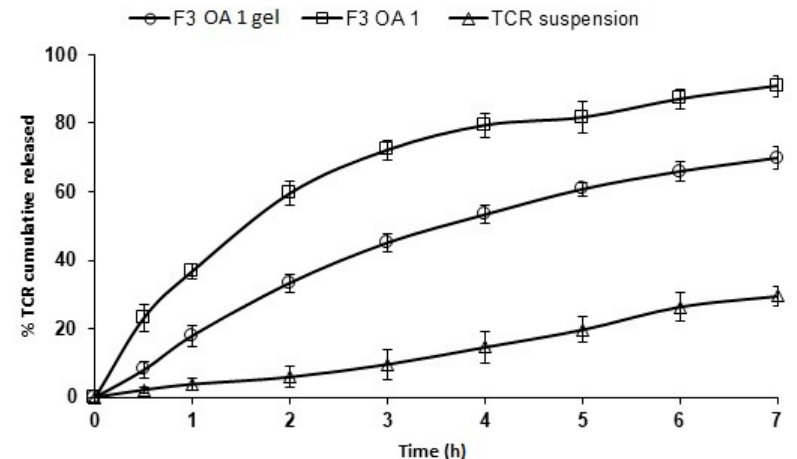
Figure 5. In vitro release of TCR from F3 OA 1 SPL gel, and F3 OA 1 SPLs ( n = 3, mean ± SD).